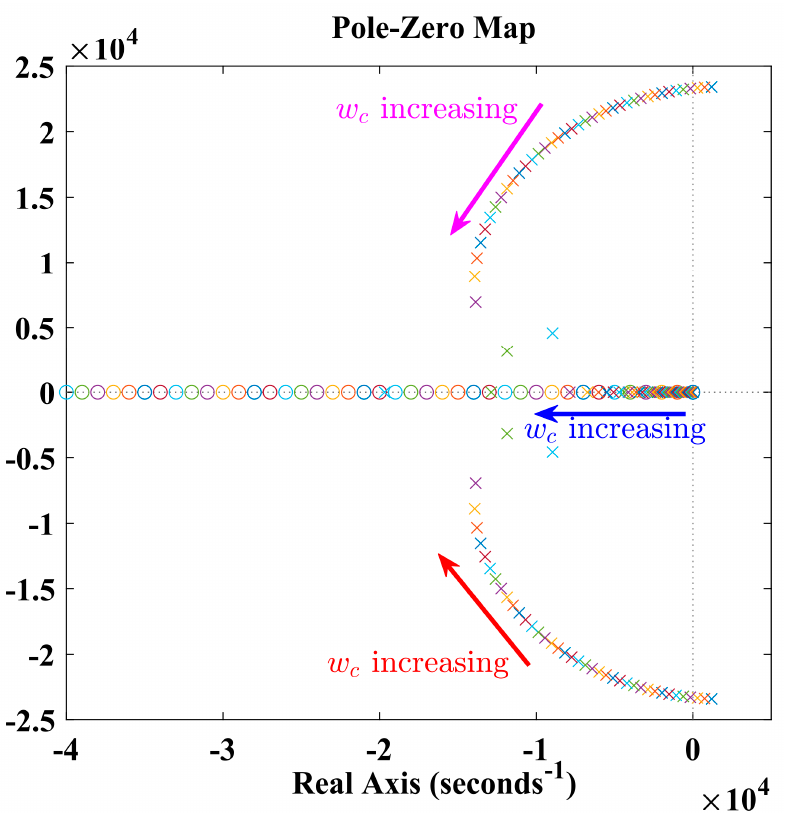
o ( s ) / d ( s ) given in (10)